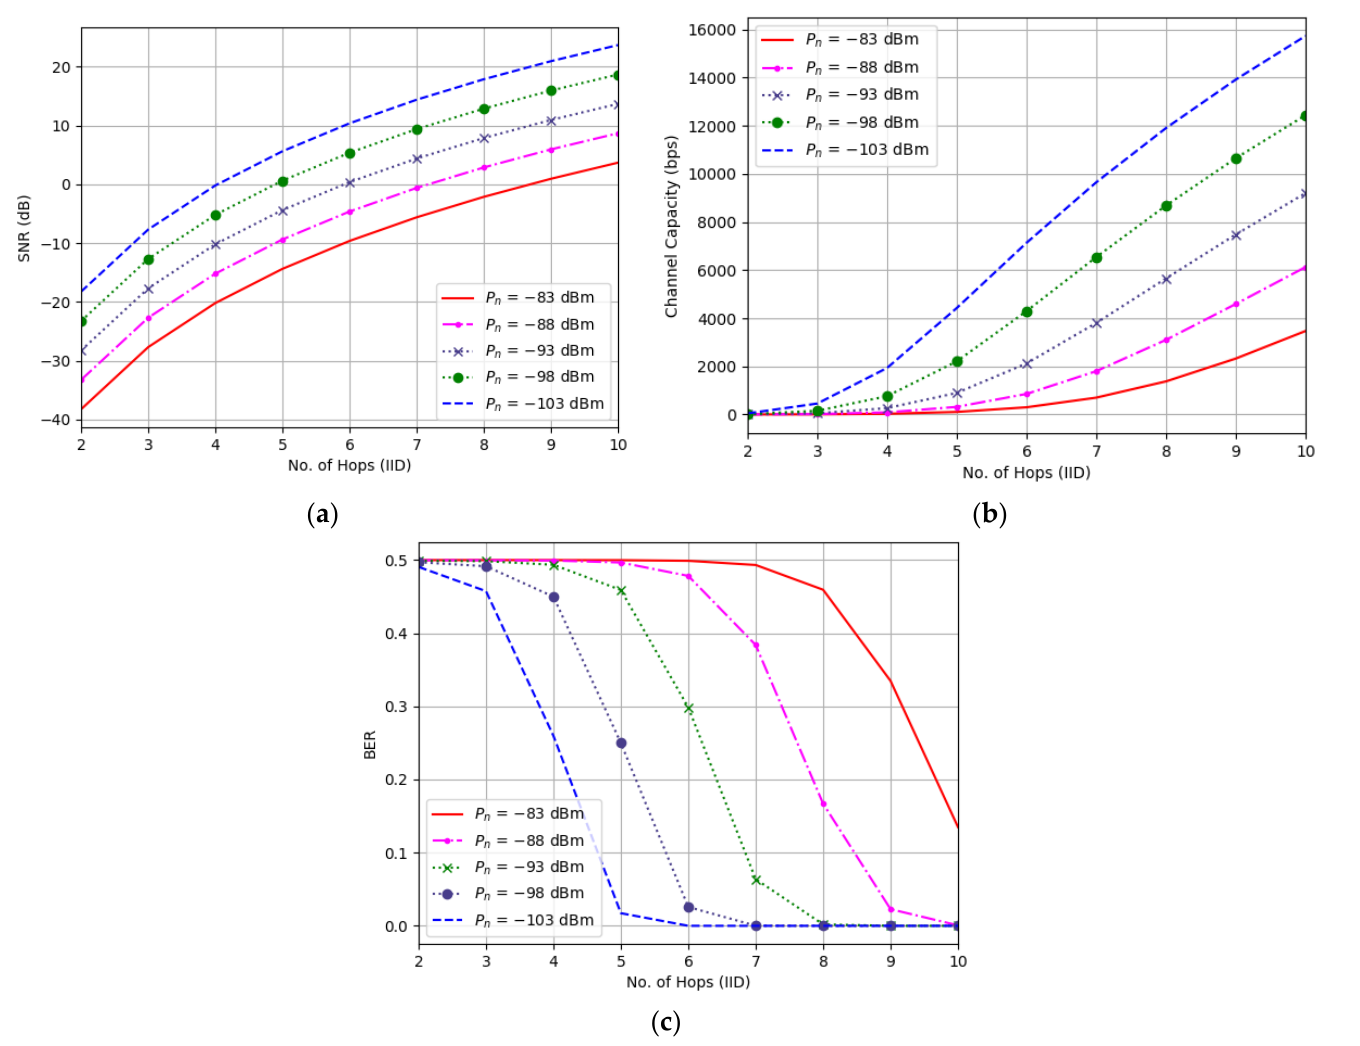
Figure 7. Multihop underground MI communication system’s performance with IID of channel states between hops. The panels show the variation of the ( a ) SNR (dB), ( b ) channel capacity (bps) and ( c ) BER with the number of hops under different noise conditions.